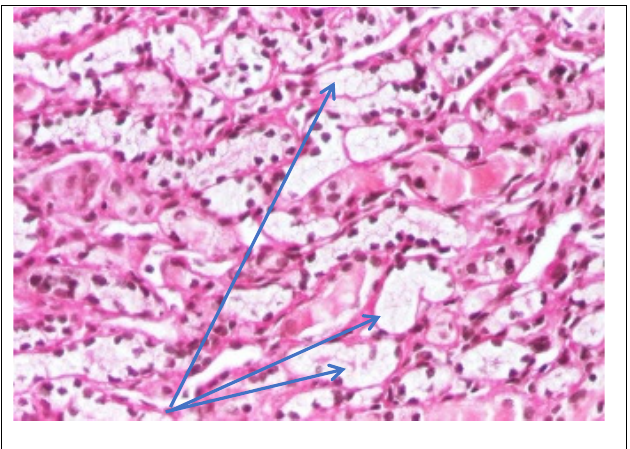
Figure 4. Kidney biopsy ( PAS staining × 200)—Fibrinoid deposits in the glomerulus and PAS+ wall thickened vessel (blue arrow).